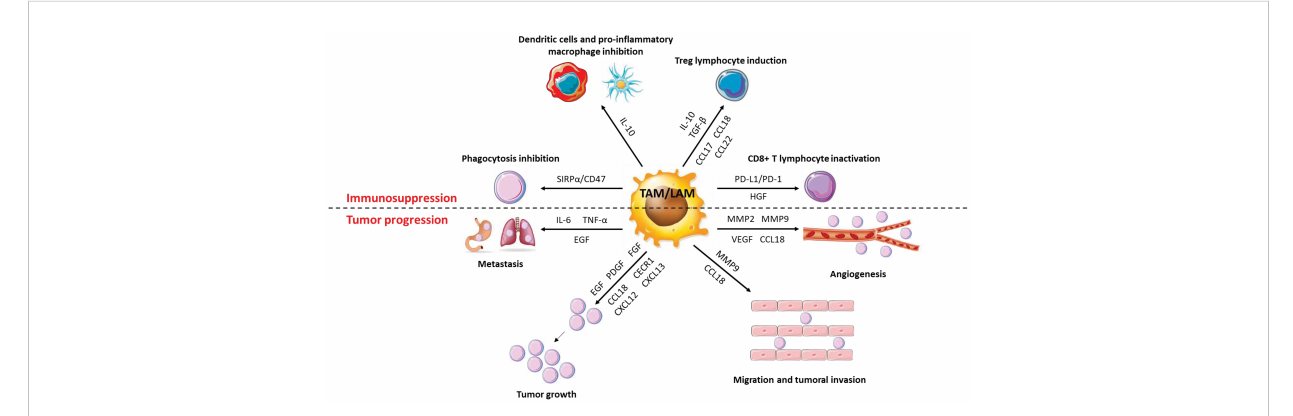
FIGURE 6 Role of macrophages in cancer progression. TAMs have a very diverse activity pro fi le to promote cancer cells. They promote the growth and metastatic potential of cancer cells by secreting numerous molecules (cytokines, chemokines, growth factors, etc.) that act directly or indirectly on them. Thus, TAMs disrupt the anti-tumor response and promote angiogenesis, tumor growth and metastatic